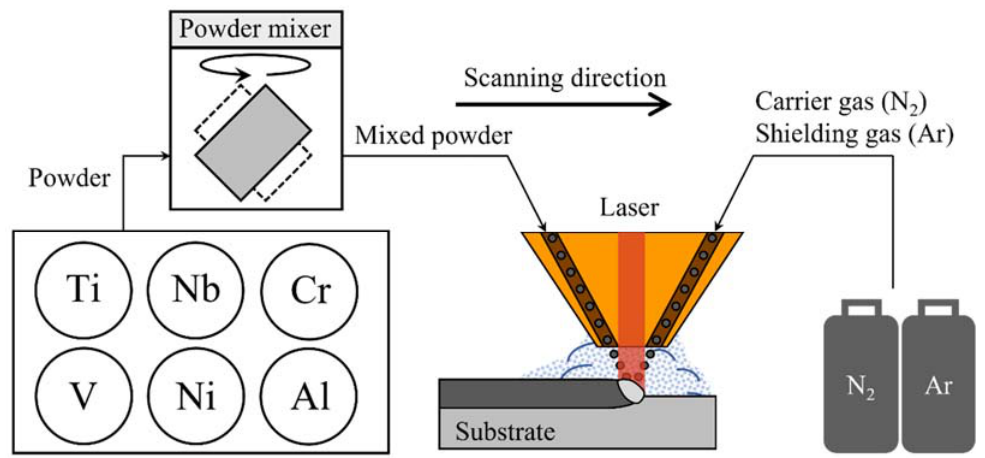
Figure 1. Schematic diagram for DED of Ti-Nb-Cr-V-Ni-Al.